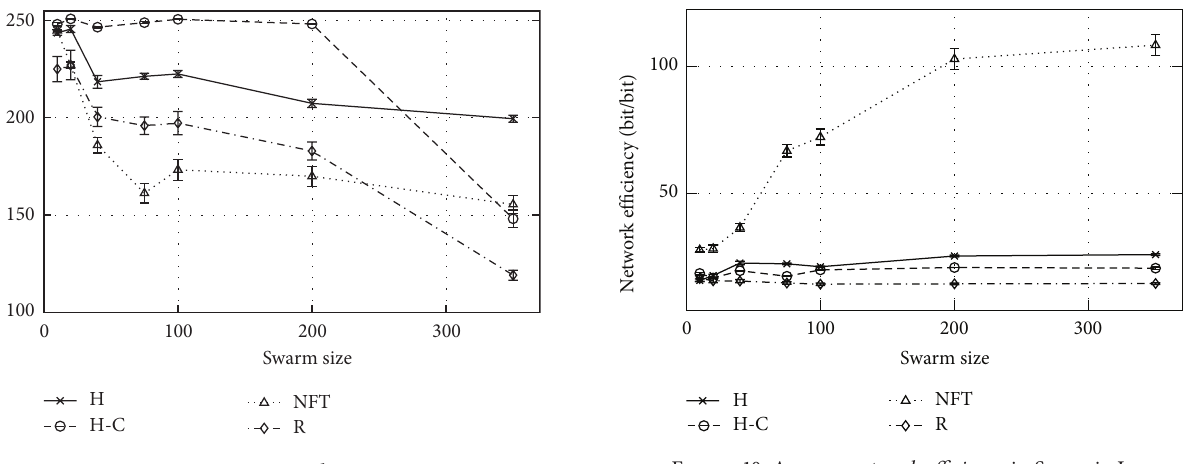
Figure 8: Average peer speed in Scenario I.